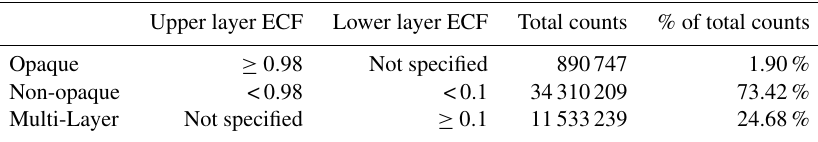
Table 3. Definitions of the three ice cloud categories using the AIRS two-layer effective cloud fraction (ECF) product, the total counts and relative counts (%) of the three cloud categories. These results are obtained over the tropical oceans ( ± 18 ◦ ) during July and August from 2003 to 2016.